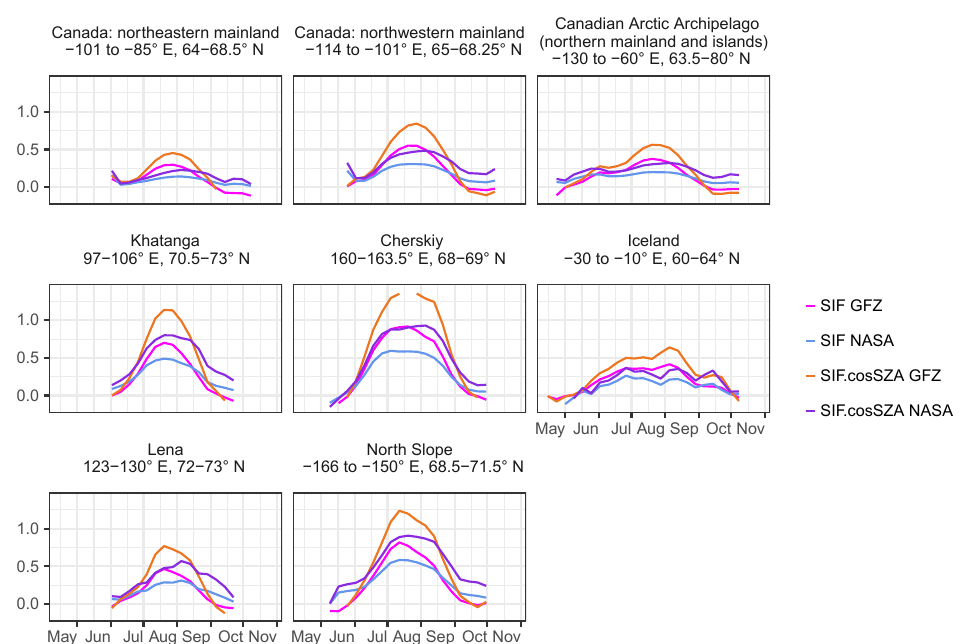
Figure A16. Mean seasonal cycles of SIF data from GOME-2 for the two retrievals GFZ and NASA. Values are given in mW/(m 2 srnm).